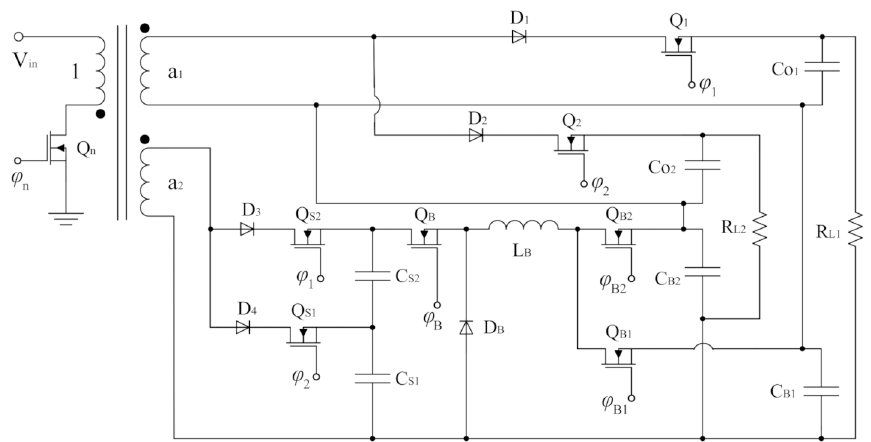
Figure 2. Topology of the proposed single-input multiple-output (SIMO) power supply based on the master-slave